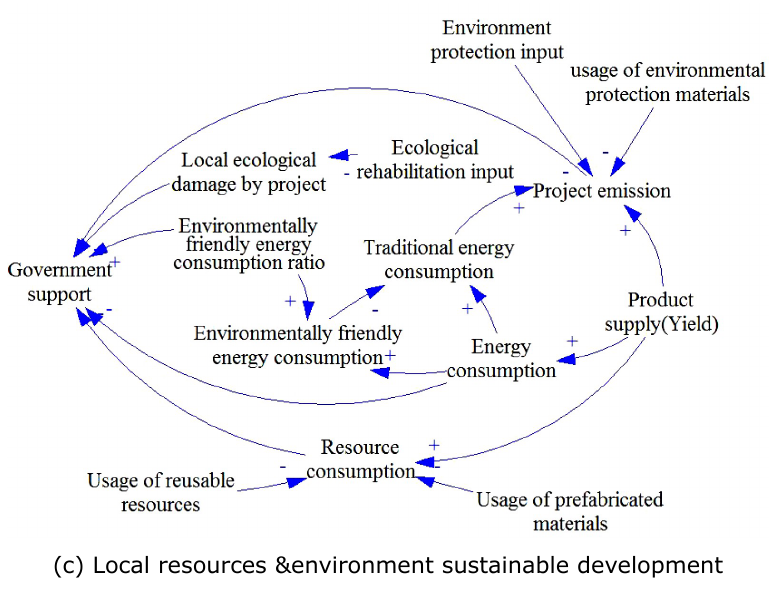
Figure 4. The causal loop diagrams of four